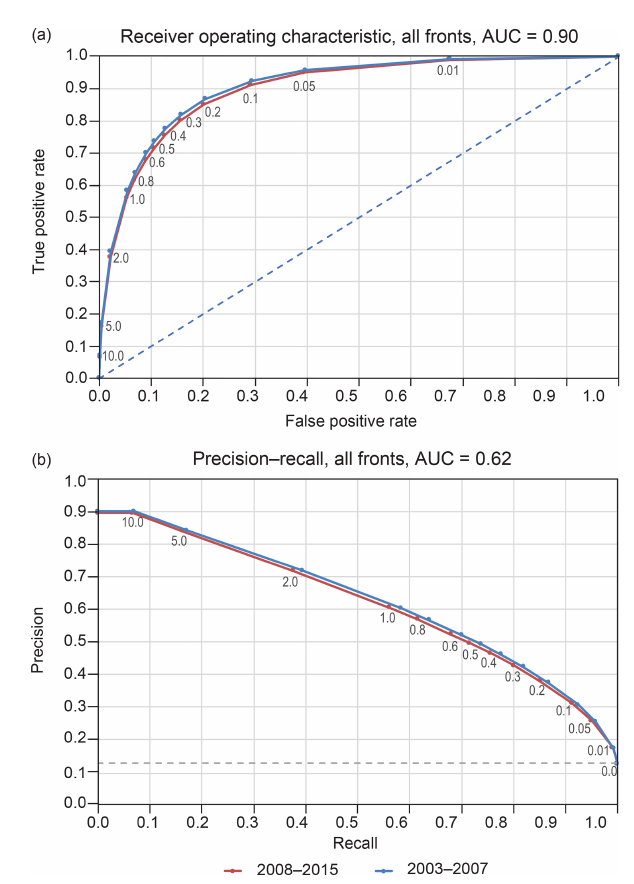
Figure 6. Maps of seasonal front crossing rate climatologies (2003– 2015) for the CSB and DL-FRONT